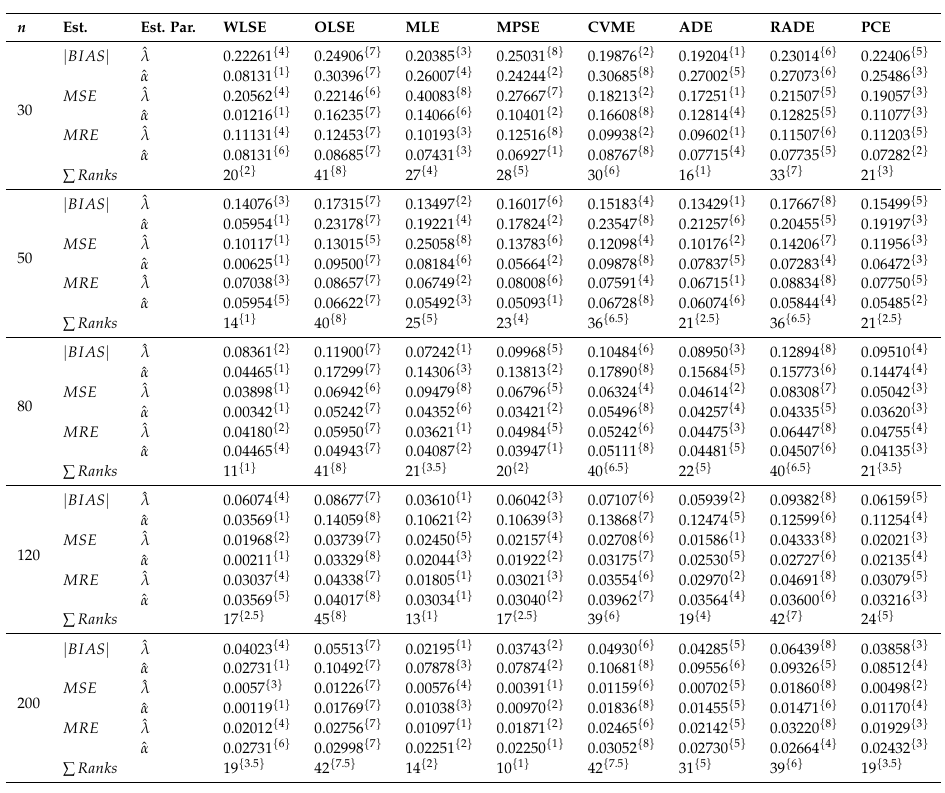
Table 5. Simulation results for φφφ = ( λ = 2.0, α = 3.5 ) (cid:124)